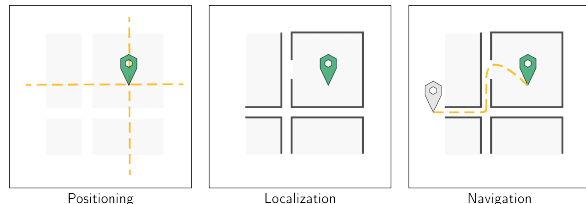
Figure 2. Differences between positioning, localization and navigation for indoor situations.